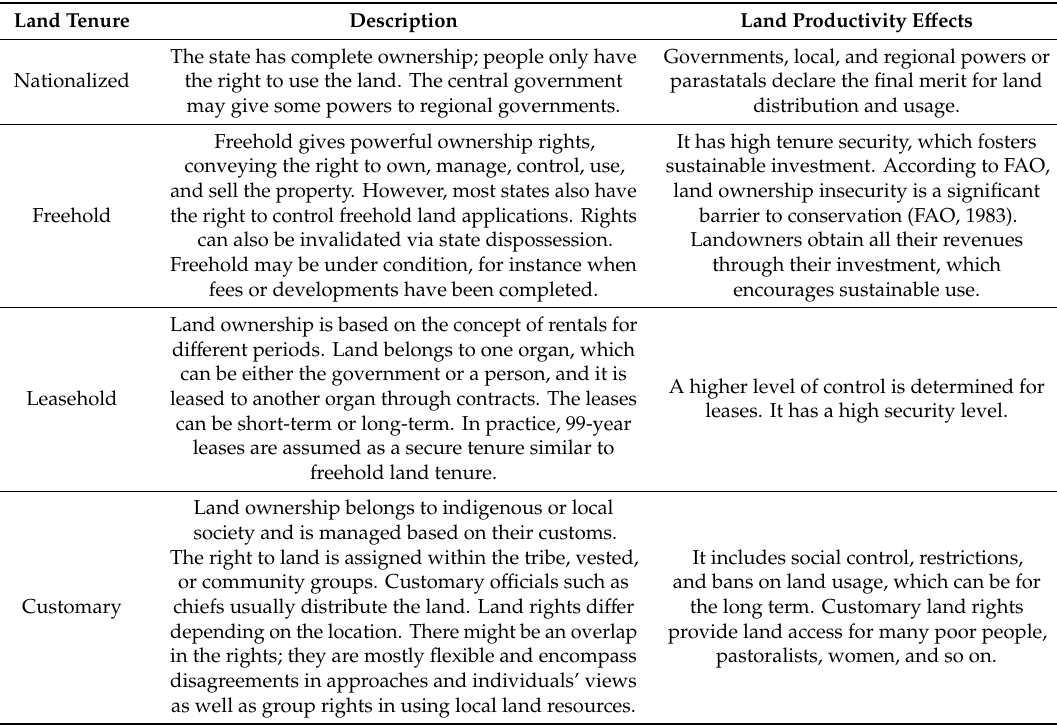
Table 1. The main land-tenure